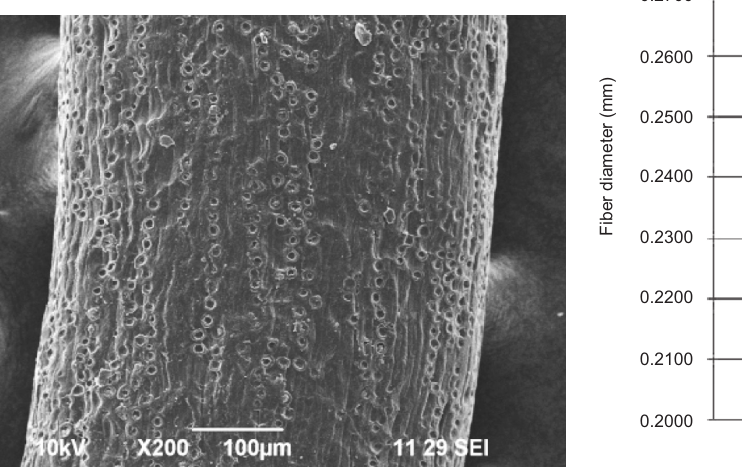
Figure 6 Coir fiber diameter before and after NaOH